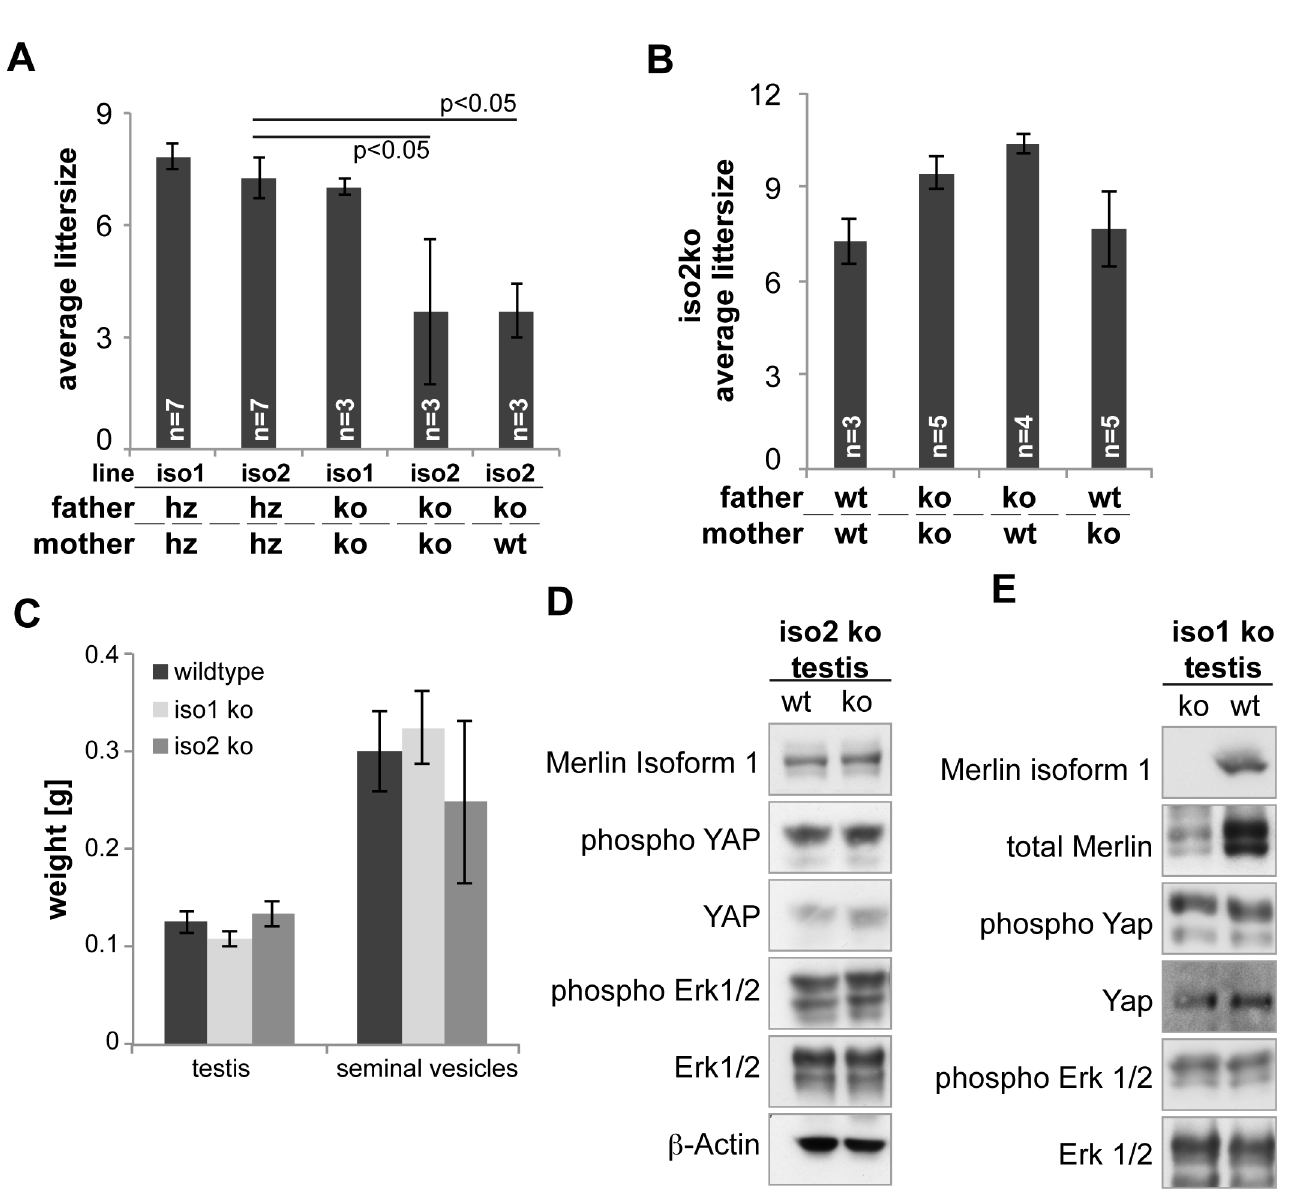
Fig 6. Classical merlin regulated pathways are unaltered in ko testes. Average littersize of different breeding combinations over a period of 6 months, starting at 2 months of age, on a C57Bl/6 (A) and a mixed C57Bl/6-FVB/NJ (B) genetic background revealed a background dependent impact of the isoform 2 knockout on fertility. (C) Testis and seminal vesicle weight of both knockout lines was unchanged at 3 months (n = 5). (D) and (E) Western blot analysis of whole testis lysates indicated unaltered Hippo (phospho Yap) and MAPK (phospho Erk) signalling in both knockouts. Knockout of isoform 1 led to altered merlin protein levels in iso1 ko testis (E) .